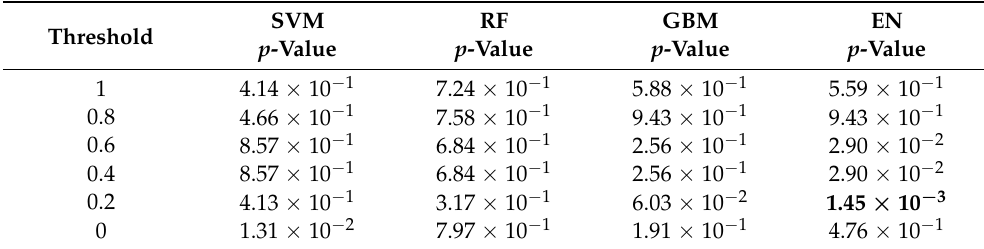
Table 5. Enrichment test of the predicted targets for SCZ (for targets of bipolar disorder listed in